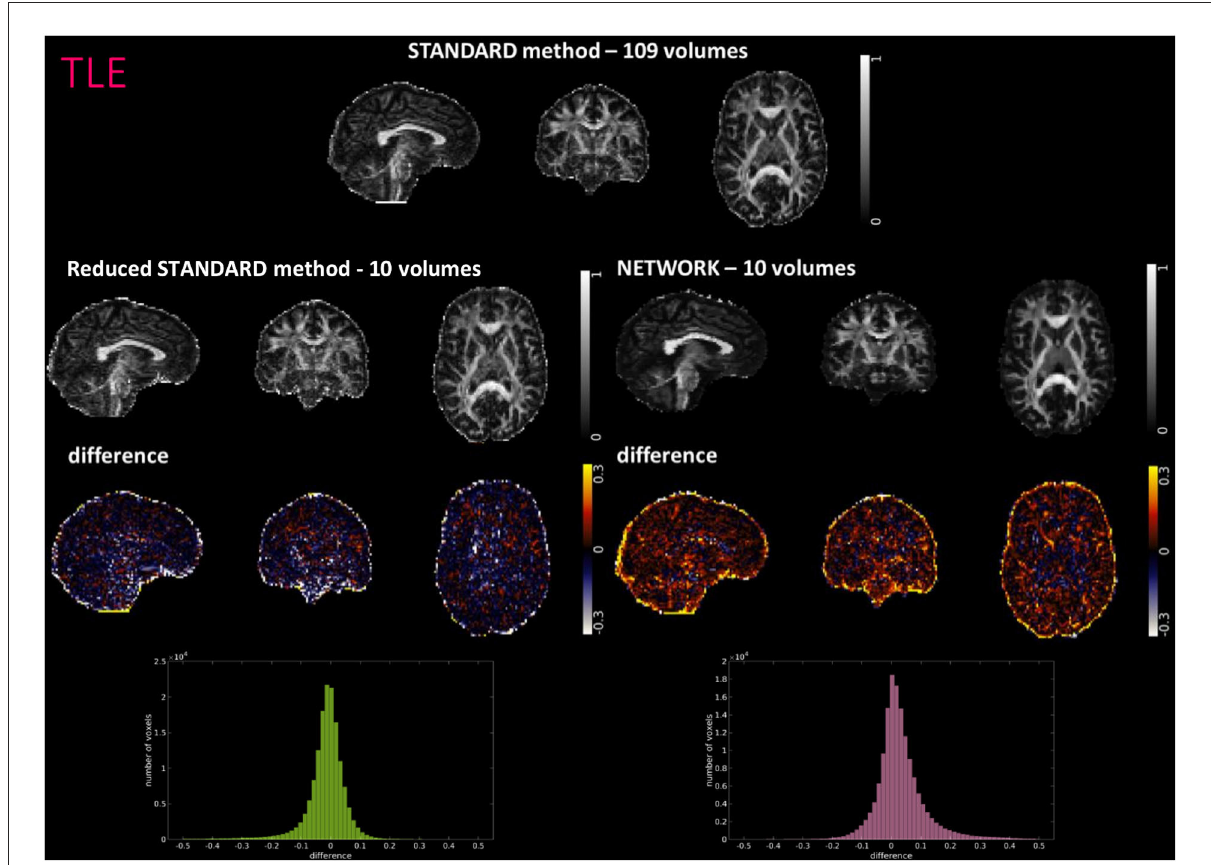
FIGURE5 For a random subject from the temporal lobe epilepsy (TLE) study, each fractional anisotropy (FA) map is shown: the standard FA map calculated with model fitting from all diffusion-weighted (DW) volumes (STANDARD method − 109 volumes), the standard FA map calculated with model fitting from a DW subset of 10 volumes (Reduced STANDARD method-10 volumes), and the network FA map from a DW subset of 10 volumes used as input (NETWORK-10 volumes). The “difference” shows the voxel-wise difference between the (STANDARD method − 109 volumes) FA and either the (Reduced STANDARD methods − 10 volumes) FA or the (NETWORK − 10 volumes) FA maps. At the bottom, there is the histogram of the differences. All color bars have arbitrary units (a.